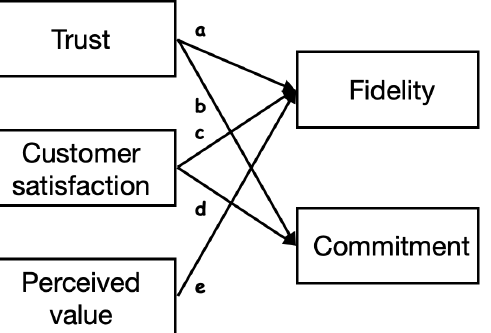
Figure 2. Composition of the Fidelity and Commitment